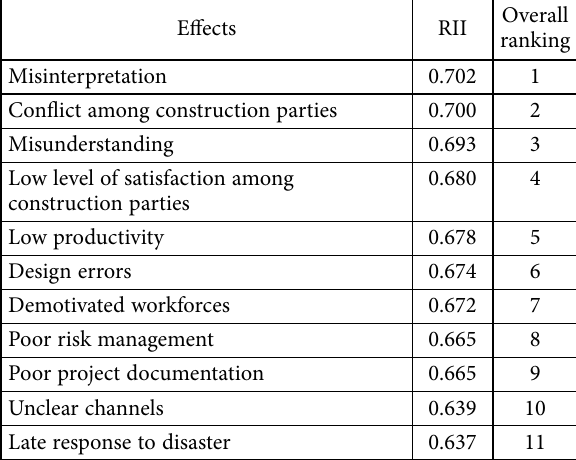
Table 9. RII and ranking of the effects of poor